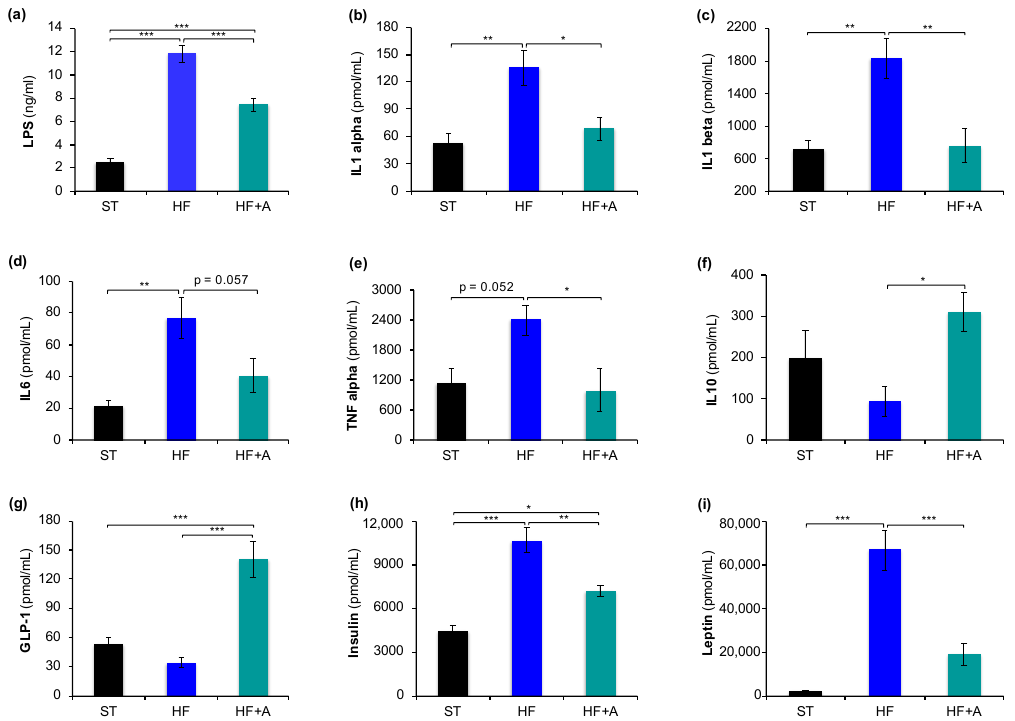
Figure 3. Agavins consumption decreased LPS and pro-inflammatory cytokine levels as well as insulin and leptin hormones in mice fed high-fat diet. ( a ) Concentration of LPS; ( b ) IL-1 α ; ( c ) IL-1 β ; ( d ) IL-6; ( e ) TNF- α ; ( f ) IL-10; ( g ) GLP-1; ( h ) Insulin; and ( i ) Leptin. Data are shown as average ± SEM ( n = 6 / group). Data were analyzed using one-way ANOVA, followed by Tukey multiple comparison test. Significant di ff erence is indicated by * p < 0.05, ** p < 0.01 and *** p < 0.001; near-significant di ff erences are also reported. HF (mice fed with a high-fat diet); HF + A (mice fed with a high-fat diet plus agavins); ST (mice fed with a standard